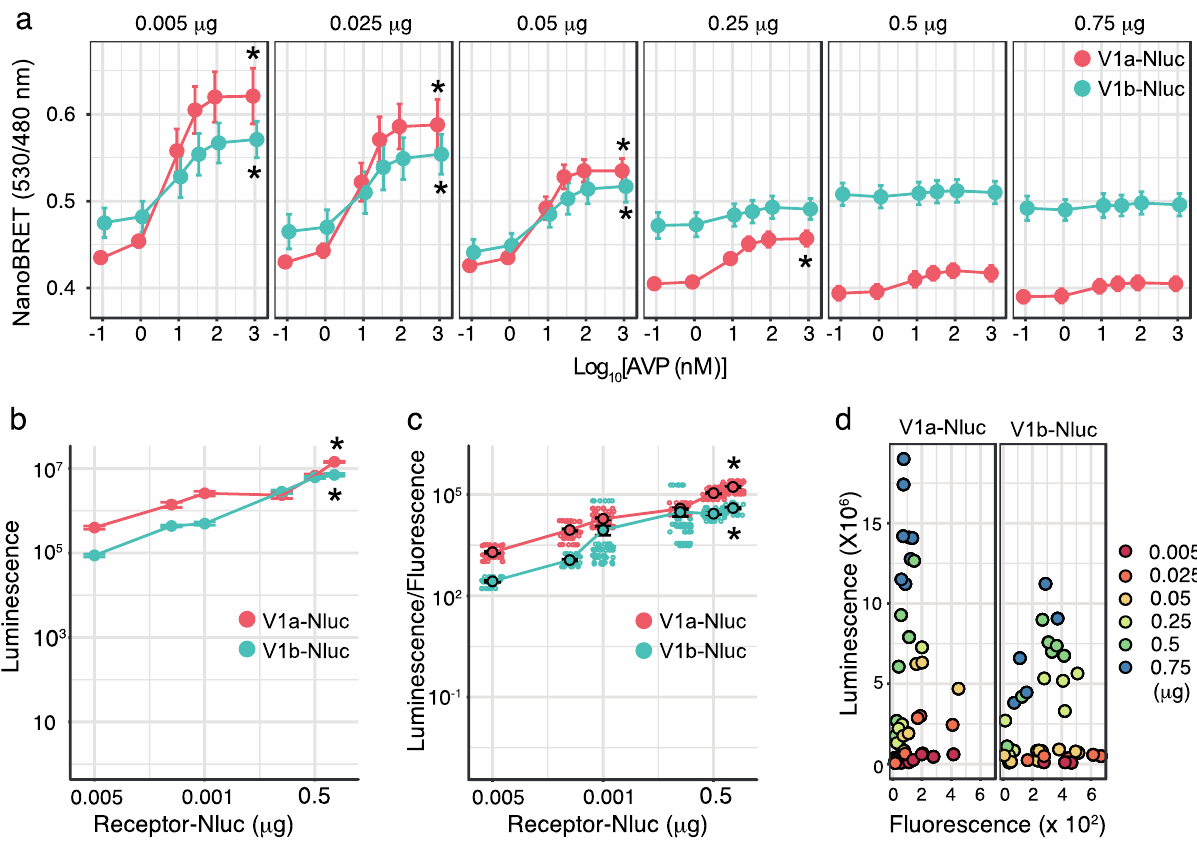
Figure 3. A reduction of receptor-Nluc expression increased the agonist-dependent BRET signals. ( a ) Plasmid DNAs encoding V1a-Nluc and V1b-Nluc were separately transfected at the indicated amounts together with 1.5 µg of β-arrestin 2-Venus into 10 5 cells in a 35 mm dish. After the cells were allowed to grow for 36 to 48 h, the AVP-stimulated increase in the BRET levels was monitored. Each concentration–response curve was constructed from 5 to 9 independent experiments. *indicates a significantly increased response compared with that induced by 0.1 nM AVP ( p < 0.05). ( b ) Increases in the transfection amount of V1a-Nluc and V1b- Nluc increased the luminescence intensities. (n = 6–9) ( c ) The ratio of Nluc luminescence/Venus fluorescence increased as the transfection amounts of the V1a- Nluc and V1b-Nluc plasmids increased. (n = 6–9) In ( b , c ), *indicates a significant increase compared with the response elicited by 0.005 μg of receptor-Nluc ( p < 0.05). ( d ) Relationship between the luminescence and fluorescence intensities during the experiments shown in ( a ). (n = 6–9) The statistical computer program R version 4.0.3 (R Core Team, [2020], Vienna, Austria. https:// www.r- proje ct. org) was used to prepare Fig.